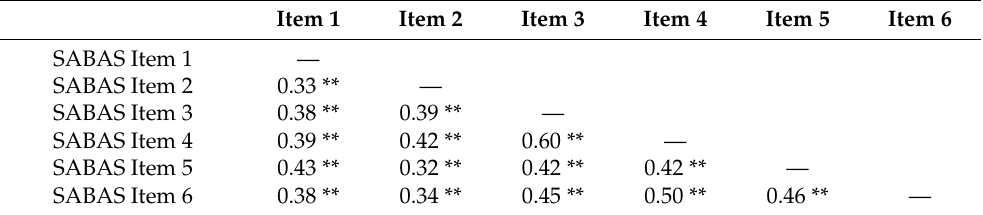
Table 3. Inter-item correlations for the Smartphone Application-Based Addiction Scale.